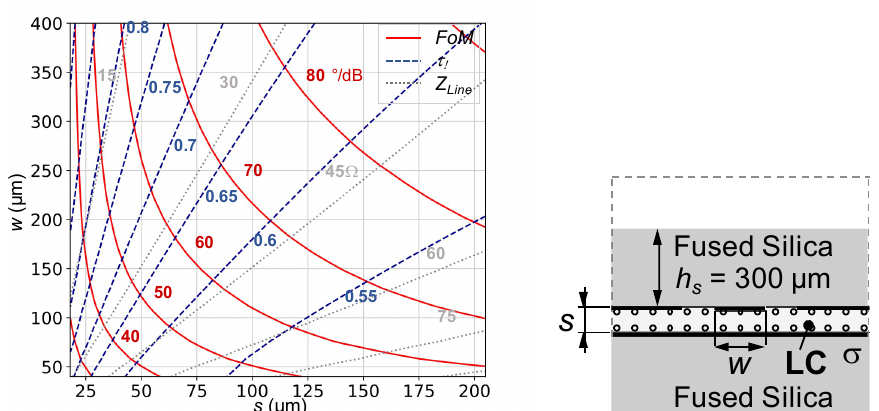
Figure 19. Plots for designing a grounded CPW phase shifter filled with LC GT3-23001 for 30 GHz ( right ). As substrate, use is made of fused silica. The electrical conductivity of the metal parts is set to σ = 4 · 10 7 S/m. These plots exhibit curves of constant phase shifter figure-of-merit (FoM, full red lines), orientation e ff ectivity τ ϕ (dashed blue lines), and line impedance Z Line (dotted gray lines), depending on the signal line width w (vertical axis) and the thickness s ≈ h LC (horizontal axis).